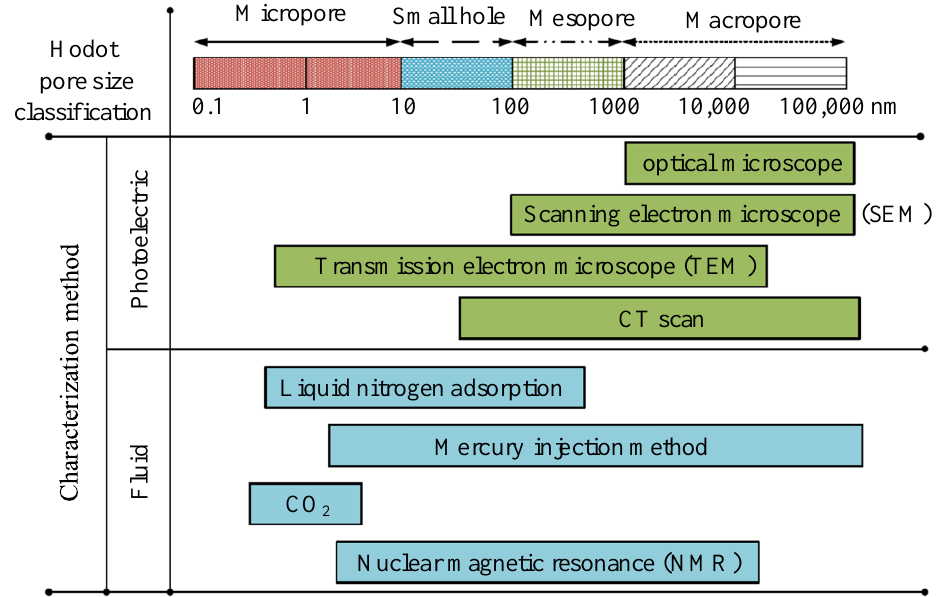
Figure 18. Pore characterization method of coal or rock mass [42].